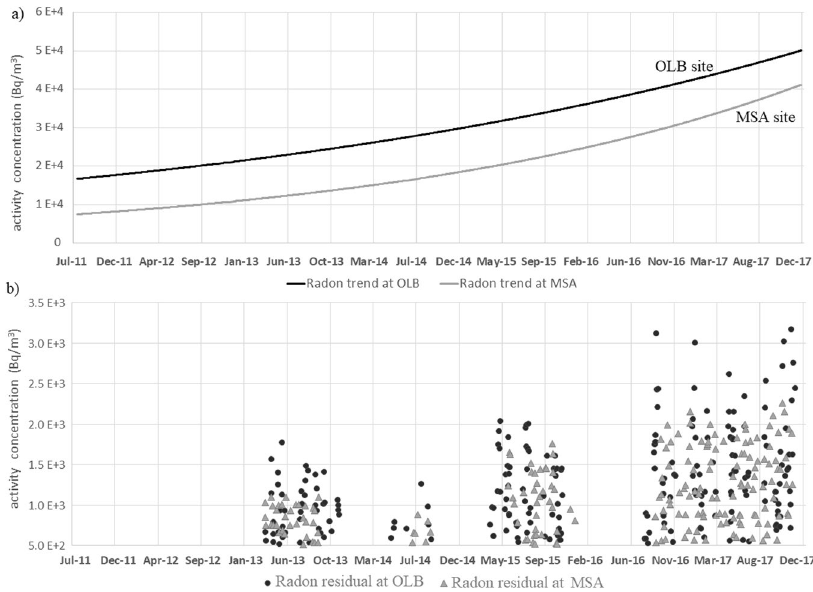
Figure 3. Radon trends and residuals. ( a ) Radon trends at OLB and MSA sites, obtained by applying the MLR + EMD hybrid method. ( b ) Radon residuals in OLB and MSA sites, obtained by subtracting the computed signals, by using the hybrid method MLR + EMD + SVR, from the raw recorded data, within a 95% CI (see section Time series analysis).